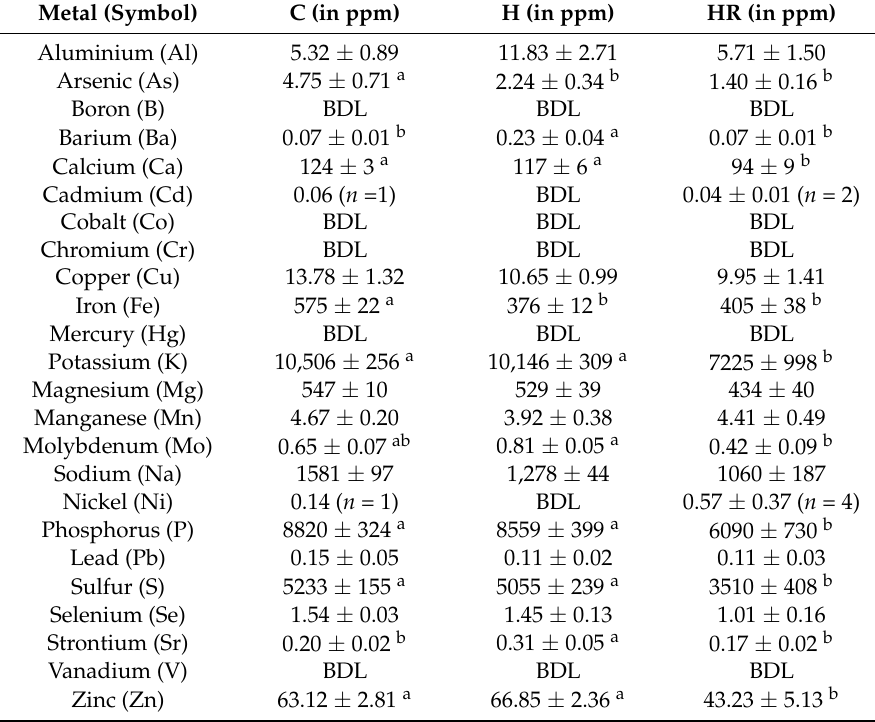
Table 2. Effects of Kappaphycus on metal and metalloid contents in liver.